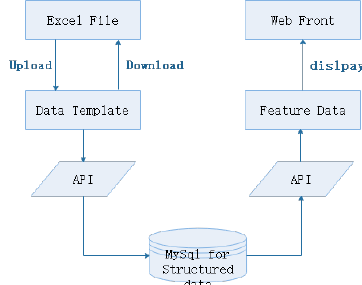
Figure 7 . Diagram of how attribute templates work.